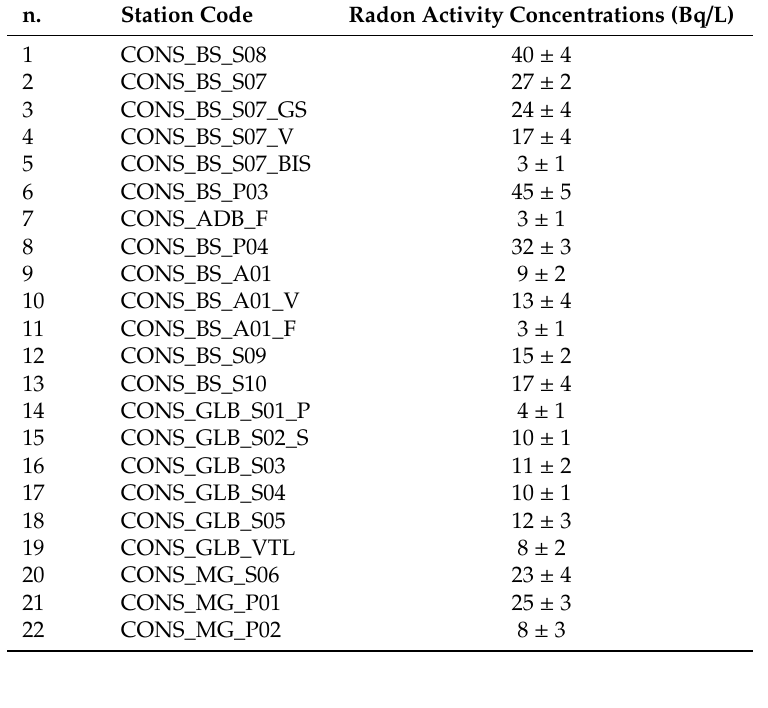
Table 2. Radon-in-water activity concentrations measured for the di ff erent chosen stations. n. Station Code Radon Activity Concentrations (Bq / L)